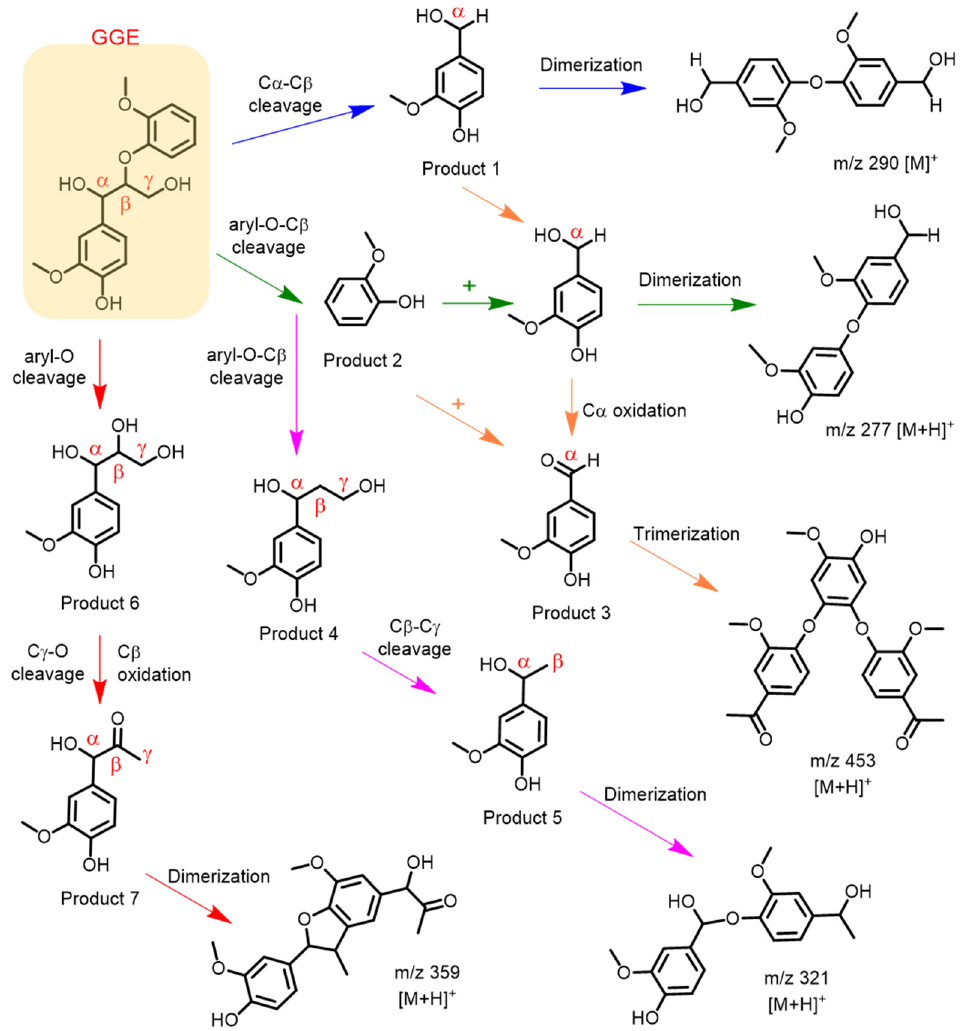
Figure 9. Depolymerization and polymerization of the GGE catalyzed by F43Y/F138W/P88W/T67R Mb. Product 1 is 4-(hydroxymethyl)-2-methoxyphenol, product 2 is guaiacol, product 3 is vanillin, product 4 is 1-(4-hydroxy-3-methoxyphenyl)propane-1,3-diol, product 5 is 4-(1-hydroxyethyl)- 2- methoxyphenol, product 6 is 1-(4-hydroxy-3-methoxyphenyl)propane-1,2,3-triol, and product 7 is 1-hydroxy-1-(4-hydroxy-3-methoxyphenyl)propan-2-one, respectively. Moreover, after the C α -C β or aryl-C α cleavage of GGE, the reaction may continue to generate product 3 (vanillin) by oxidation of C α . Then products 2 and 3 may form a heterotri- mer linked by C-O-C bonds, generating the observed molecule of C 25 H 24 O 8 with m/z 453 [M+H] + . It should be noted that the detection of vanillin from a lignin dimer was reported previously for R . jostii DypB, which revealed that the oxidative cleavage of C α -C β occurred, although dimerization via the coupling of phenoxy radicals also occurred [48]. As shown in Figure 9, upon the aryl-O-C β cleavage of GGE, in addition to product 2 , the depolymerization product 4 , (1-(4-hydroxy-3-methoxyphenyl)propane-1,3-diol), may also be generated. It will be further cleaved by C β -C γ to produce product 5 , (4-(1-hydroxyethyl)-2- methoxyphenol). Product 5 may undergo dimerization to form a dimer, with the molecular formula of C 17 H 20 O 6 . Alternatively, GGE may be cleaved by the aryl-O bond, producing prod- uct 6 , (1-(4-hydroxy-3-methoxyphenyl)propane- 1,2,3-triol). Furthermore, it will produce product 7 , (1-hydroxy-1-(4-hydroxy-3- methoxyphenyl)propan-2-one), by both C γ -O cleav- age and C β oxidation of product 6 , which will also form a dimer, with a molecular weight corresponding to the molecular formula of C 20 H 22 O 6 ( m/z 359) that has an RT of 2.919 min.